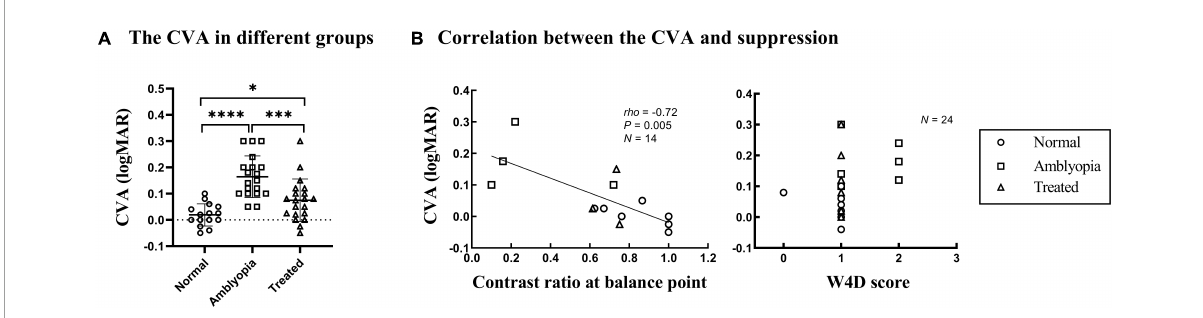
FIGURE3 CVA in the three groups and correlation with suppression. Each dot represents the results of one patient. (A) The CVA in three groups. ∗∗∗∗ P < 0.0001; ∗∗∗ P < 0.001; ∗ P < 0.05. (B) CVA as a function of the contrast ratio at the balance point tested by the binocular phase combination task in Experiment 1 and the W4D scores tested in Experiment 2. The greater the contrast ratio at the balance point is close to 1, the more balanced or less suppressed.